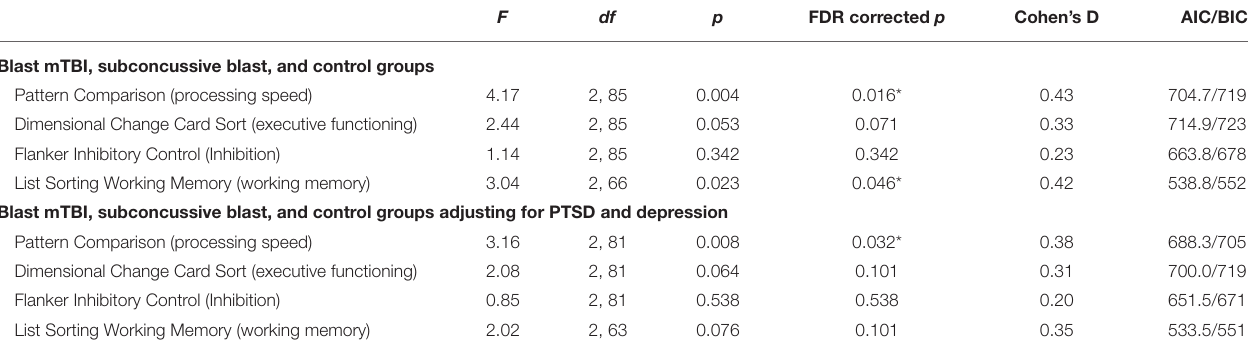
TABLE 2 | Differences in neuropsychological functioning by group. F df p FDR corrected p Cohen’s D